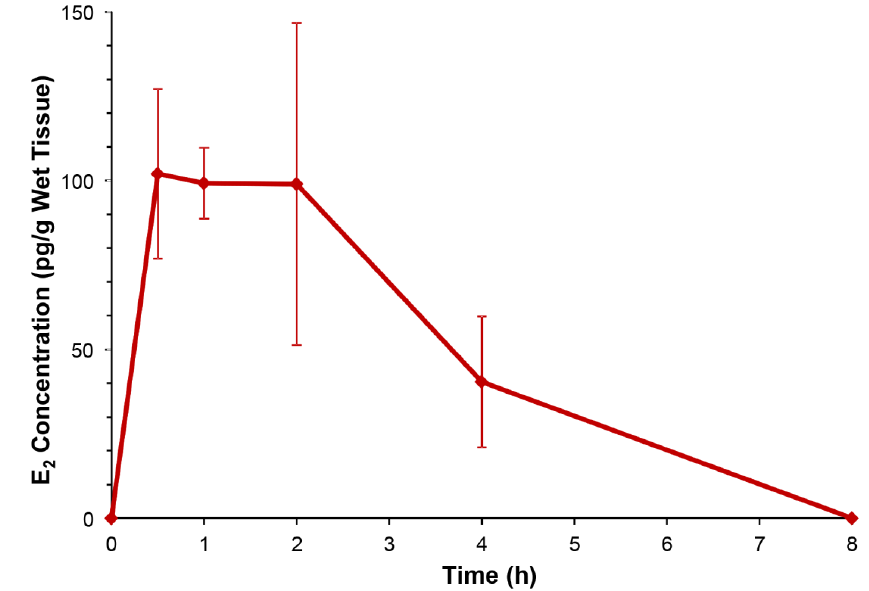
Figure 2. E 2 concentrations in the hypothalamus of orchidectomized (ORDX) rats after oral (p.o.) administration of DHED (100 µ g / administration of DHED (100 µg/kg).